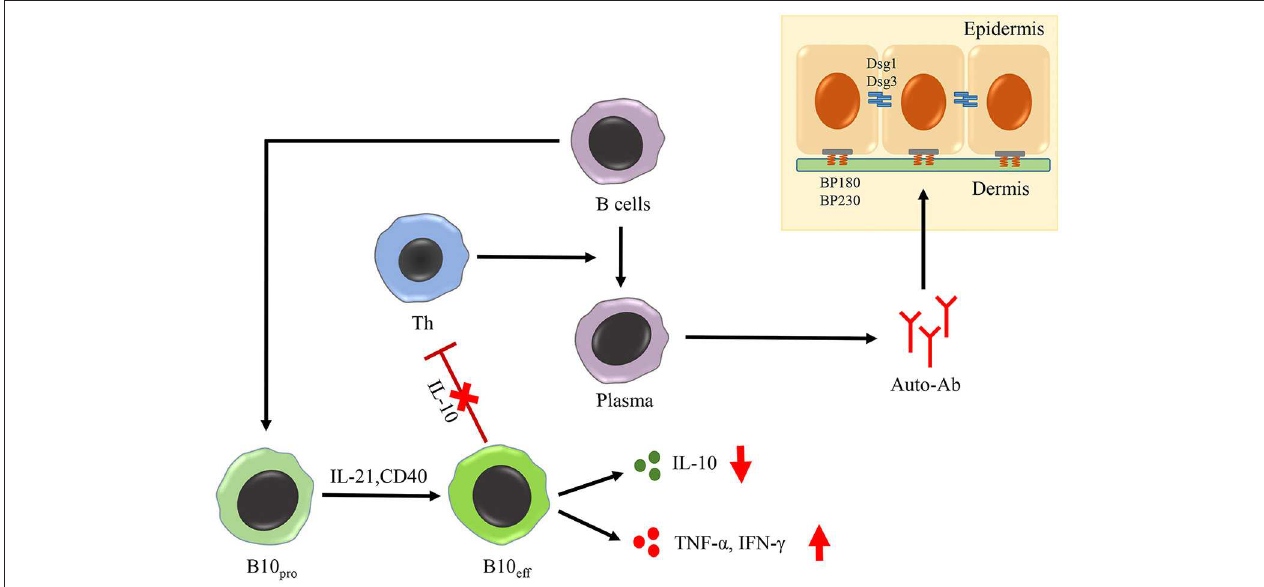
FIGURE 3 | Role of Breg cells in AIBD. The maturation of B10 pro cells into B10 eff cells requires IL-21- and CD40-dependent cognate interactions with T cells. In PV, B10 eff cells is impaired in the functions of secreting IL-10 and down-regulating the production of IFN- γ in CD4 + T cells. Moreover, Breg cells from BP patients acquire the function of producing TNF- α and IFN- γ , two important inflammatory cytokines in the pathogenesis of BP.